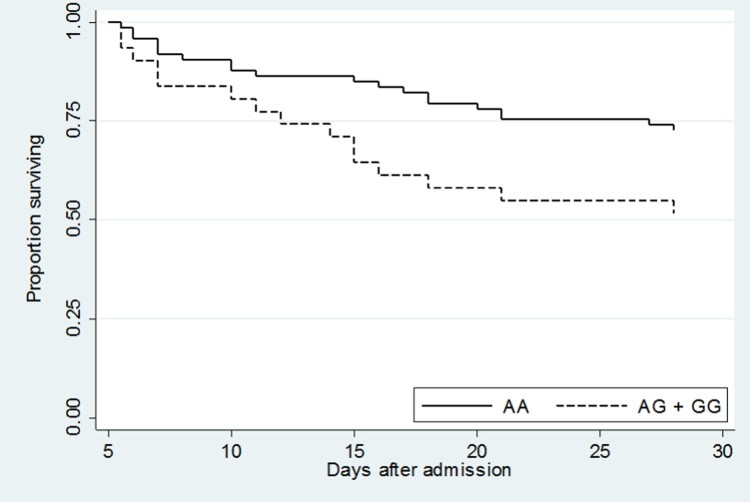
Kaplan–Meier survival curve of validation set subjects who were alive and hospitalized 5 days following admission demonstrated significantly lower survival in rs76600635 carriers (AG + GG) compared to non-carriers (AA). P = 0.03.